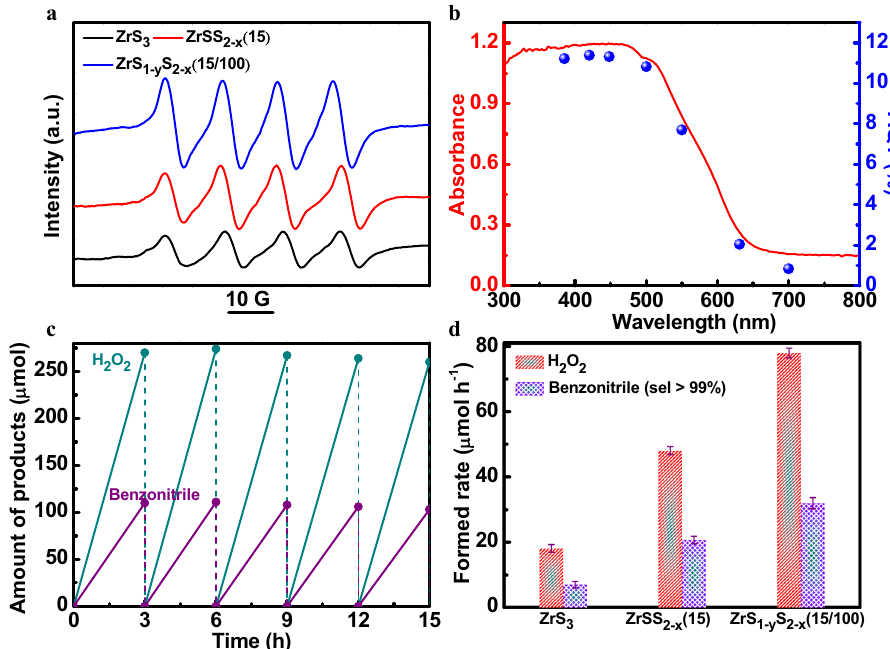
Fig. 4 The photocatalytic properties of defective ZrS 3 NBs. a EPR spectra of ZrS 3 , ZrSS 2-x (15) and ZrS 1-y S 2-x (15/100) in the presence of DMPO. b Absorption spectrum of ZrS 1-y S 2-x (15/100) and its dependence of AQY with monochromatic light irradiation. Conditions: 30 ml aqueous solution with 1 mmol benzyl alcohol, 50 mg photocatalysts. c Results of H 2 O 2 and benzonitrile generation for a repeated photoreaction sequence with ZrS 1-y S 2-x (15/100) under AM1.5G simulated sunlight irradiation. d H 2 O 2 and benzonitrile evolution rate by the respective photocatalysts under AM1.5G simulated sunlight irradiation. Error bars are the standard error of the mean for 9 independent samples. Conditions: 30 ml H 2 O with 1 mmol benzylamine, 50 mg photocatalysts, 1 bar O 2